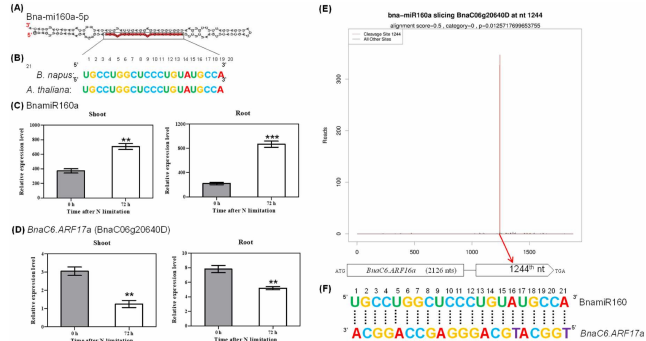
Figure 9. Molecular identification of the cleavage of ARF17 by miR160 regulating root growth. ( A ) Hairpin structures and mature sequences of Bna-miR160a. The mature miRNA sequence was marked with red color. ( B ) Mature sequence alignment of BnamiR160a between A. thaliana and B. napus . ( C , D ) Quantitative RT-PCR results showing relative expression levels of ( C ) Bna-miR160a and ( D ) its target gene BnaC6.ARF17a (BnaC06g20640D) in the shoots and roots under N su ffi ciency (0 h) and N limitation (72 h). Bars denote means ( n = 3), and errors bars indicate standard deviation. Columns denote means ( n = 3), and error bars indicate standard deviations. **, p < 0.01; ***, p < 0.001; ns, not significant. ( E ) Target plot (t-plots) of representative Bna-miRNA160a targets confirmed by degradome sequencing. The red lines showed the distribution of the degradome tags along the target mRNA sequences. The red arrow represented the cleavage nucleotide positions on the target gene. The x -axis indicates the nucleotide position in the target cDNA, and the y -axis indicates the number of reads of cleaved transcripts detected in the degradome cDNA library. Alignment score is the score for mismatch. Score = 0 represents perfect match and G:U = 0.5. ( F ) Sequence matching between the mature sequence of BnamiR160a and its target gene BnaC6.ARF17a